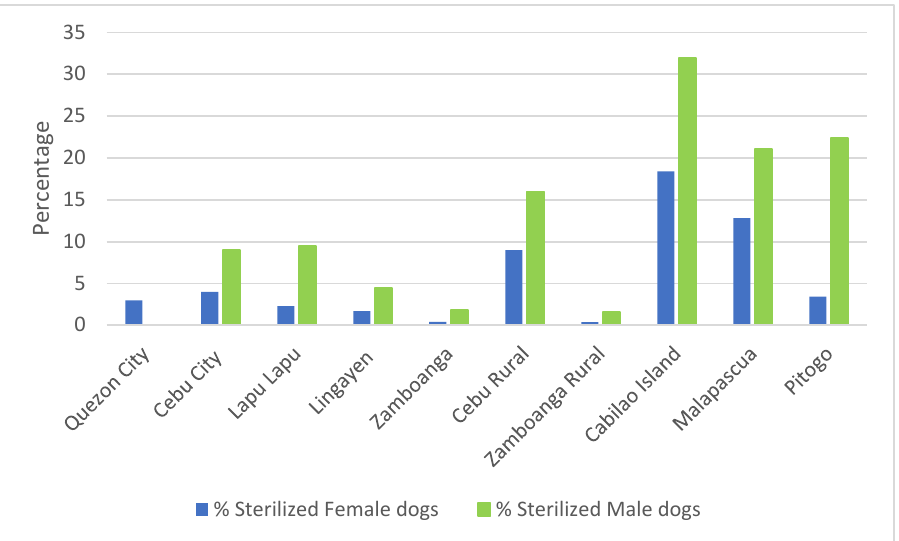
Figure 5. Percentage of male and female dogs sterilized by location . Note: male dogs were not recorded in Quezon City.